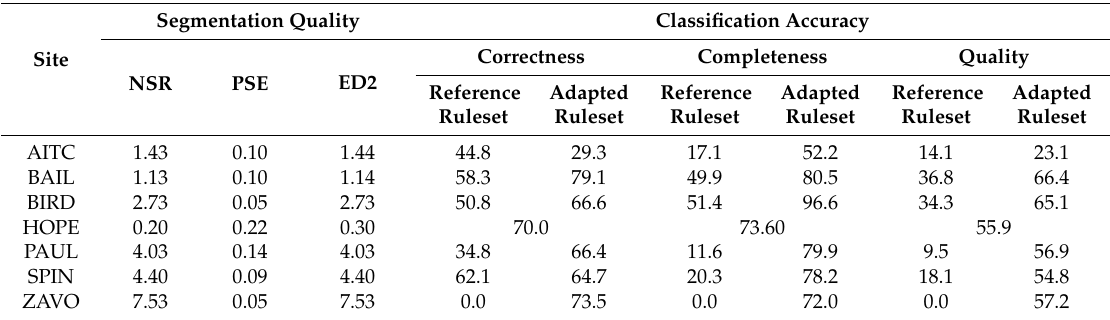
Table 3. A site-wise summary of segmentation quality and classification